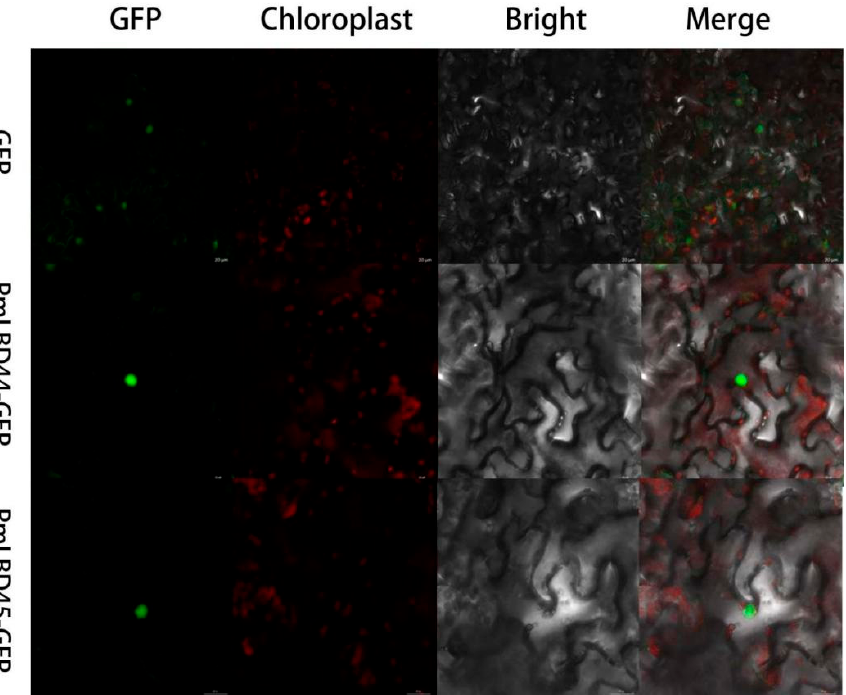
Figure 2. Subcellular localization map of PmLBD44 and PmLBD45 in leaves of Nicotiana benthamiana . Empty 121-GFP is localized in the whole cell, and 121-PmLBD-GFP is localized in the nucleus. Scale bar = 20 µ